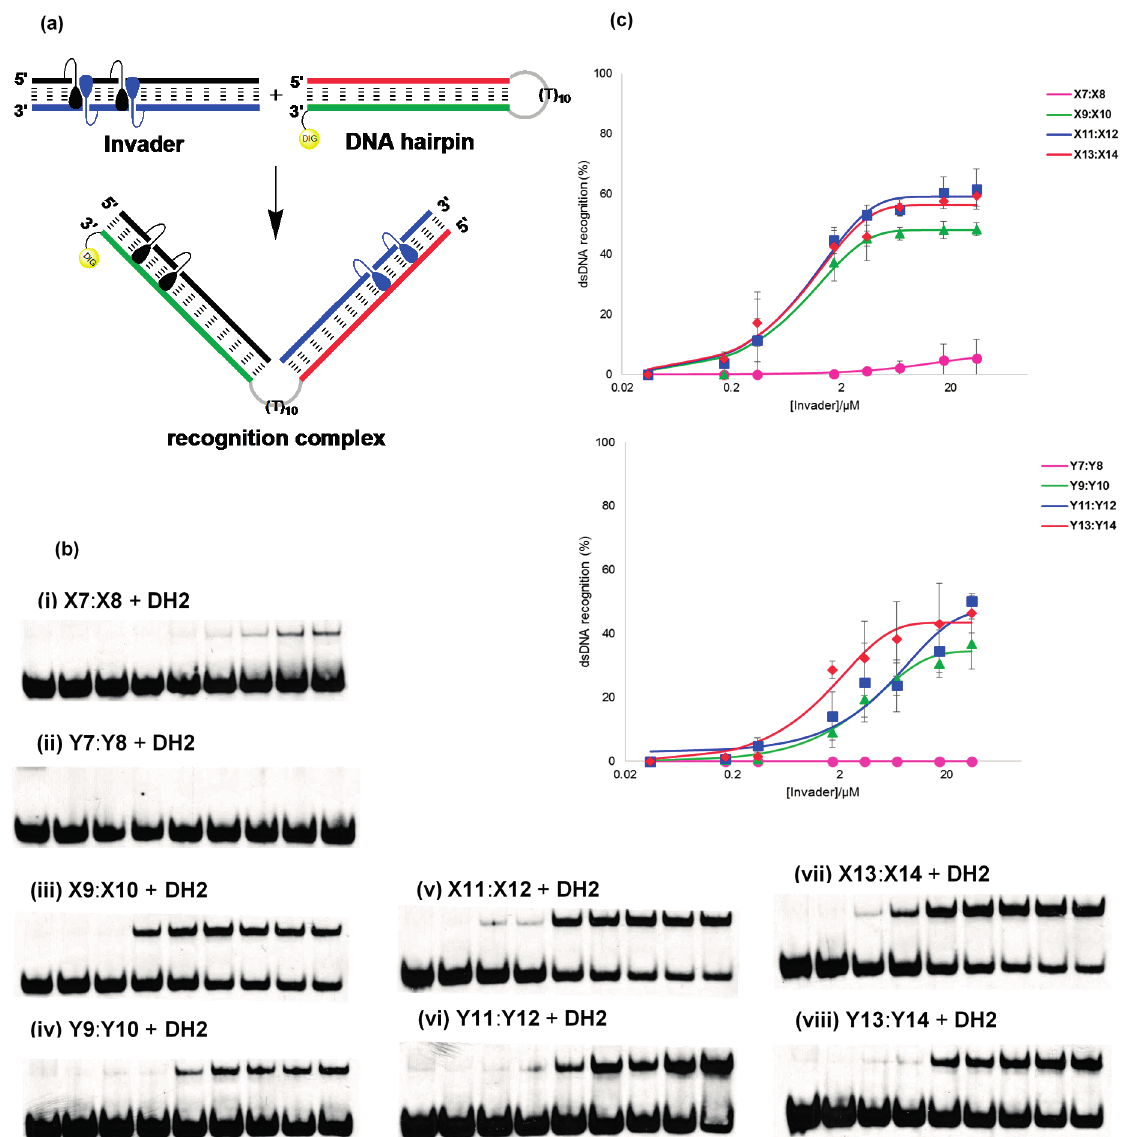
Figure 3. Recognition of dsDNA model target DH2 using different Invader probes. ( a ) Illustration of recognition process; ( b ) representative electrophoretograms for recognition of DH2 using no (lane 1) or 1-/5-/10-/50-/100-/200-/500-/1000-fold excess (lanes 2–9) of X and Y- modified 13-mer Invader probes (i–viii); ( c ) dose-response curves (average of at least three independent experiments, error bars represent standard deviation). Experimental conditions for electrophoretic mobility shift assay: separately pre-annealed targets (34.4 nM) and probes (variable concentrations) were incubated for 12–16 h at room temperature in 1X HEPES buffer (50 mM HEPES, 100 mM NaCl, 5 mM MgCl 2 , 10% sucrose, 1.4 mM spermine tetrahydrochloride, pH 7.2) and then run on 16% non-denaturing PAGE (70 V, 2.5 h, ~4 °C) using 0.5× TBE as a running buffer (45 mM Tris, 45 mM boric acid, 1 mM EDTA); DIG: